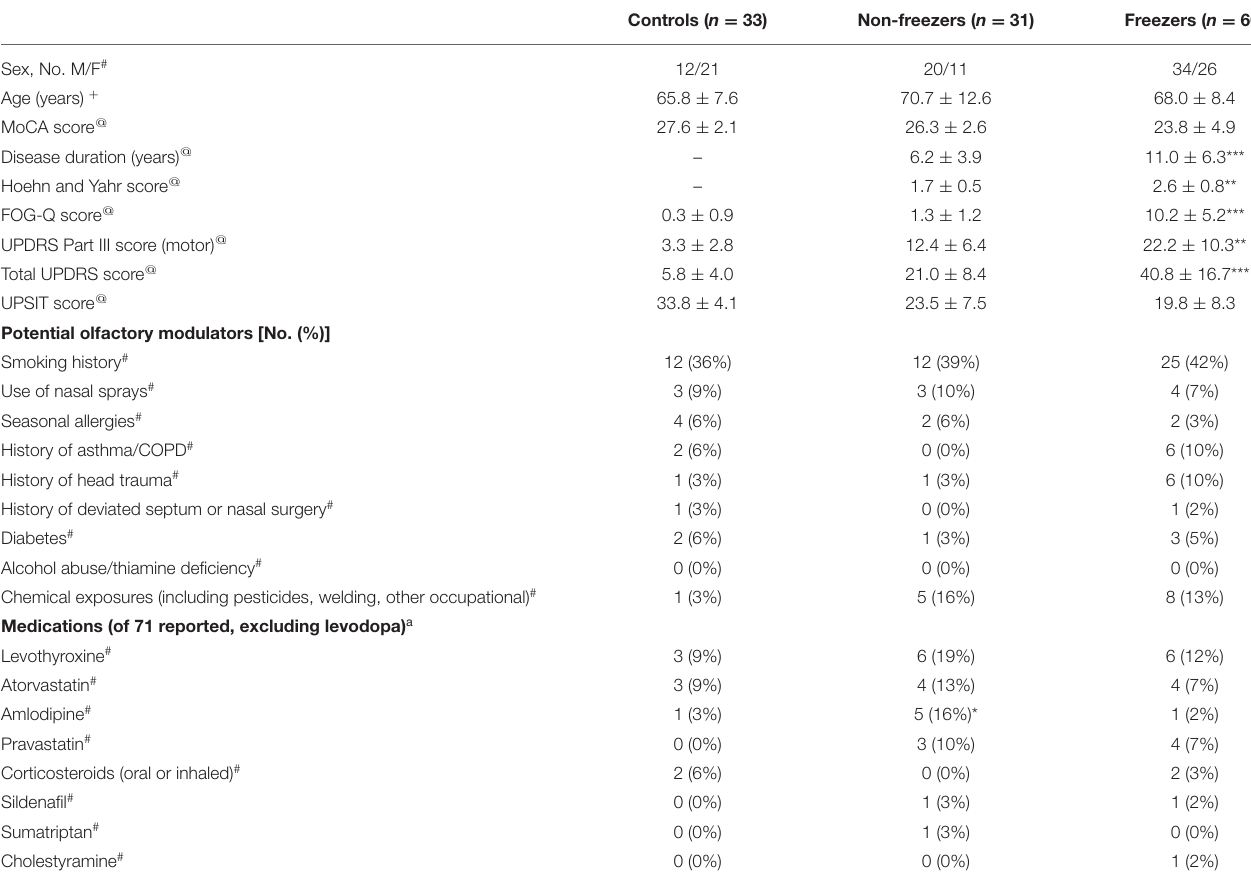
TABLE 1 | Participant demographics and potential olfactory modulators.